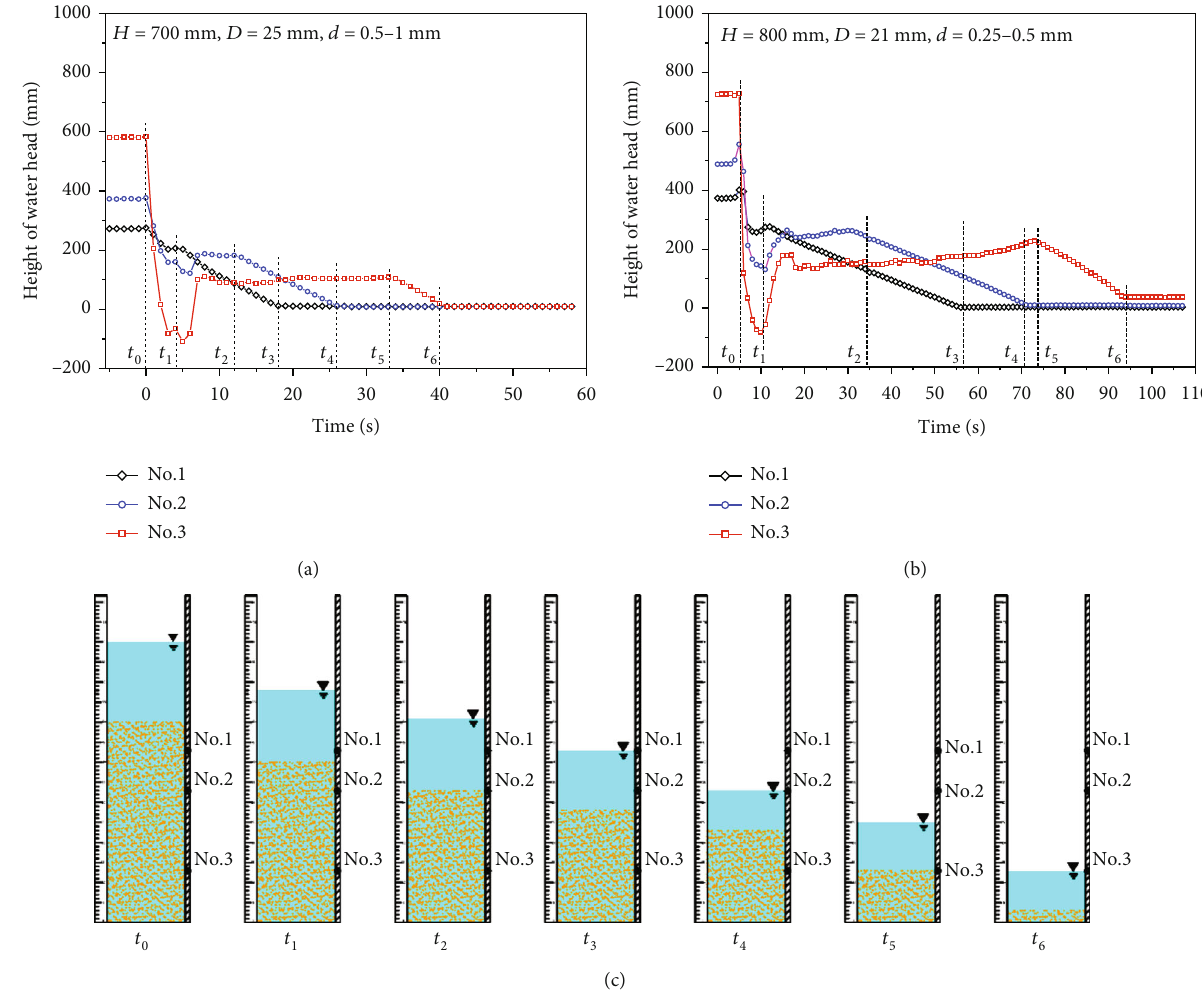
Figure 6: Variation of the height of water head vs. time for (a) ð H , D , d Þ = ð 700, 25, 0 : 5 – 1 Þ , (b) ð H , D , d Þ = ð 800, 21, 0 : 25 – 0 : 5 Þ and the corresponding schematic (c) during sand and water